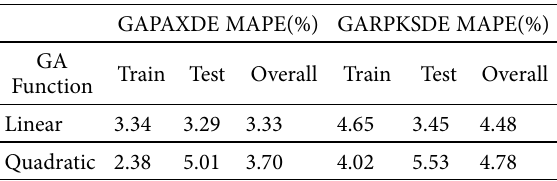
Table 3. The MAPE values of the GAPAXDE and GARPKSDE models.